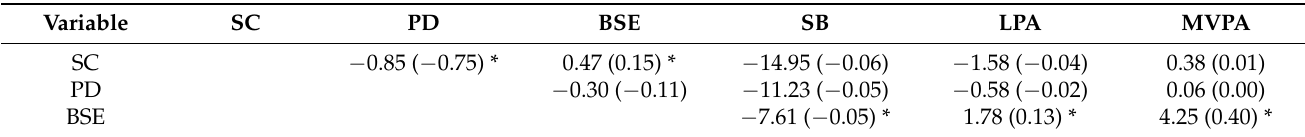
Table 2. Unstandardised and standardised direct effect of hypothesised